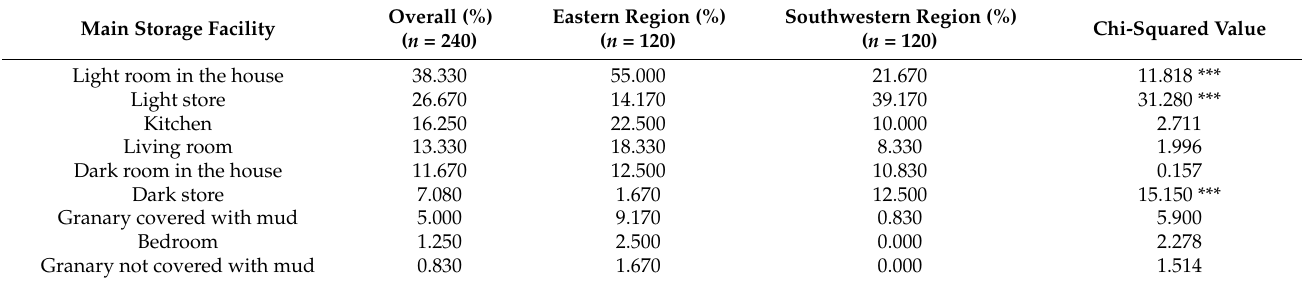
Table 6. Storage facilities used by the sampled potato farmers.